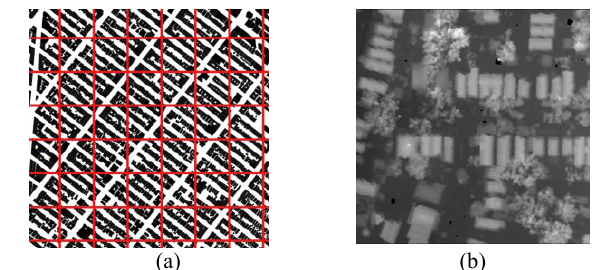
Figure 11. Data augmentation module applied on each cell for Figure 9. (a) shows the building footprints grid pattern in each building footprint F that is located with this cell Brooklyn overlaid with the training cell grid. (b) shows LiDAR values on one data sample where height values for all buildings are almost identical.